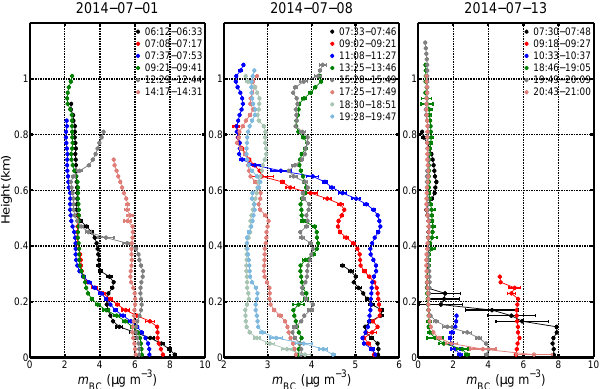
Figure 6. Vertical distributions of BC separately displayed for 1, 8, and 13 July. Profiles collected at different time are shown in differ- ent colors. As in Fig. 4, dots represent 20m averaged m BC , with standard deviations given in error bars.